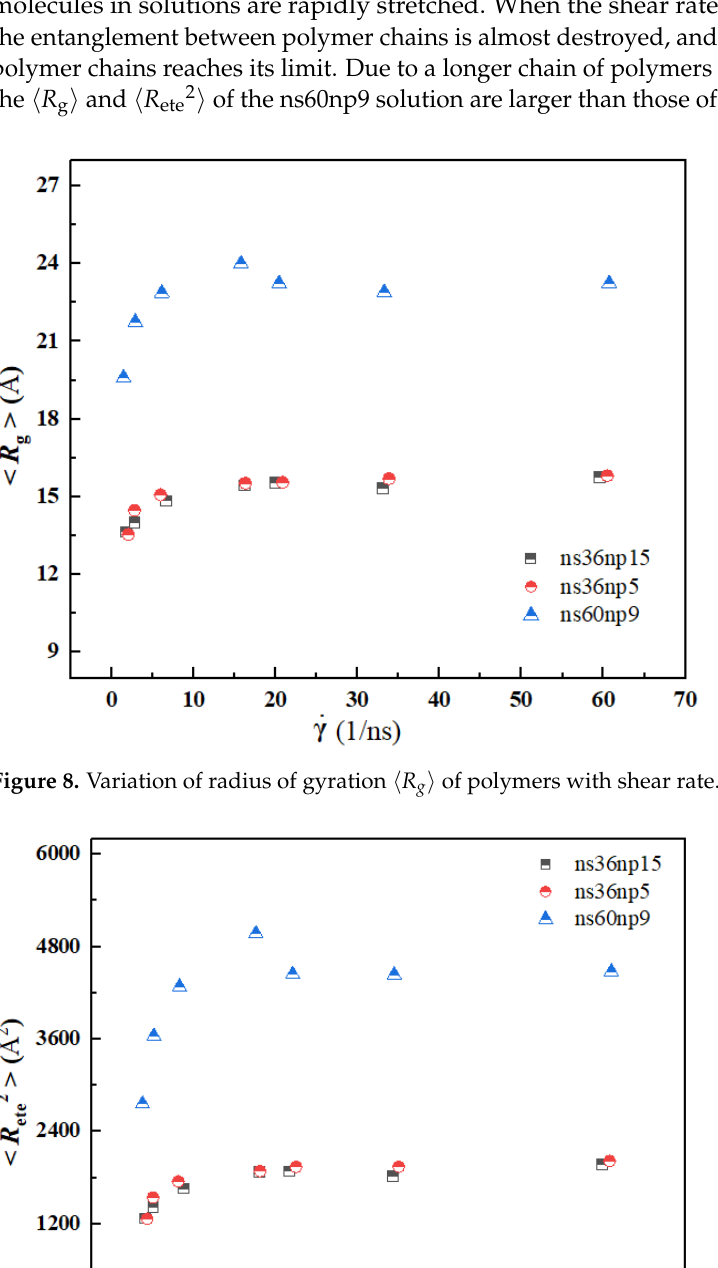
Figure 10. Variation of normalized root-mean-squared end-to-end distance 〈 R ete 〉 / L of polymers with shear rate. 4. Conclusions In this paper, the coarse-grained molecular dynamics method was used to study the rheological behavior of DRA—kerosene solutions and the conformational change of polymer molecules under steady shear flow conditions. The results show that DRA molecules in the solutions are easy to entangle and form network-like structures at low shear rates and that the degree of entanglement increases with the increase in the concentration and molecular weight of the polymer. This entanglement phenomenon increases the resistance to the motion of kerosene molecules, resulting in an increase in solution viscosity at low shear rates. With an increase in shear rate, the polymer molecules tend to be oriented along the flow direction and their molecular structure changes from a roughly ellipsoid form to a form alternating between curling and stretching, which is manifested by a sharp increase in the mean-squared end-to-end distance and the radius